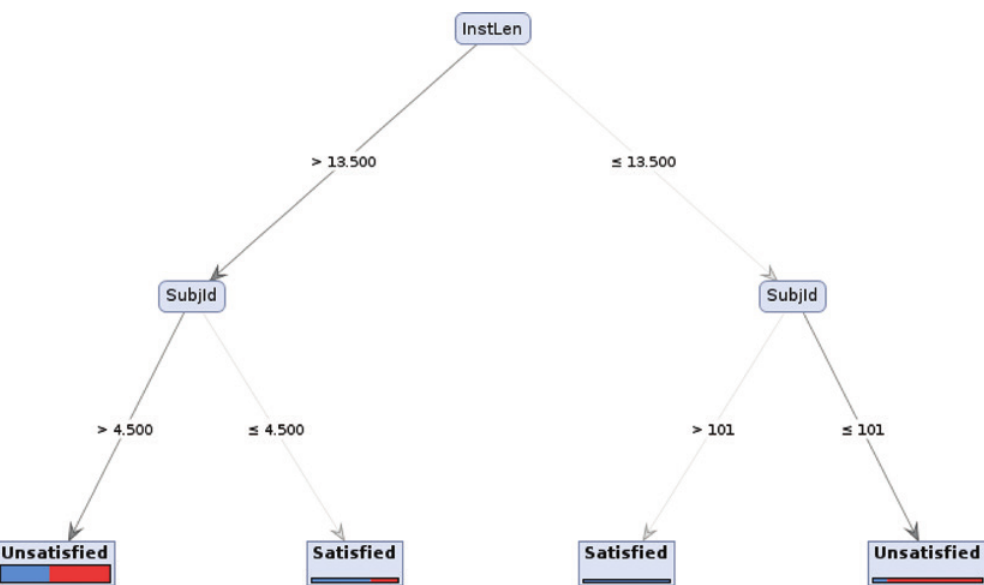
Figure 11: AI-generated tree model showing how Q22 satisfaction can be predicted from non-NSS